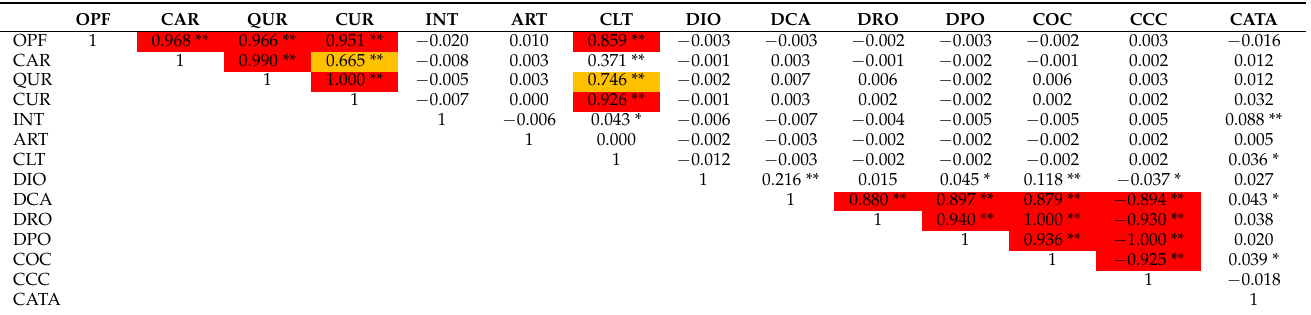
Table 6. Correlation